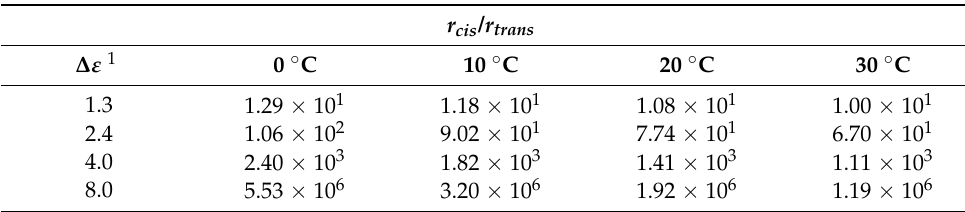
Table 2. Predicted relative desorption rates of MCHM isomers from amorphous carbon at differ- ent